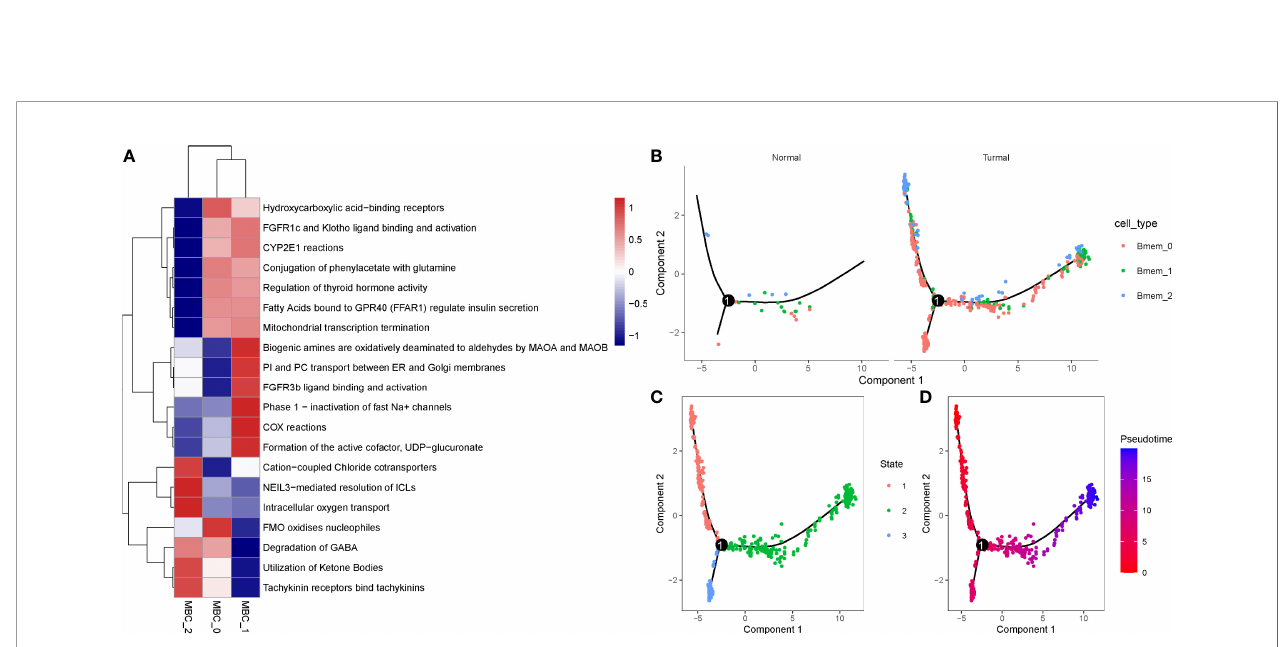
FIGURE 9 | TIDE analysis of high-risk and low-risk groups. (A – H) Comparison of TIDE score (A, E) , T cell dysfunction (B, F) , T cell exclusion (C, G) and enrichment score of MDSCs (D, H) between high-risk and low-risk groups in TCGA-PAAD (A – D) and GEO (E – H) cohorts. * P < 0.05, ** P < 0.01, and **** P < 0.0001.